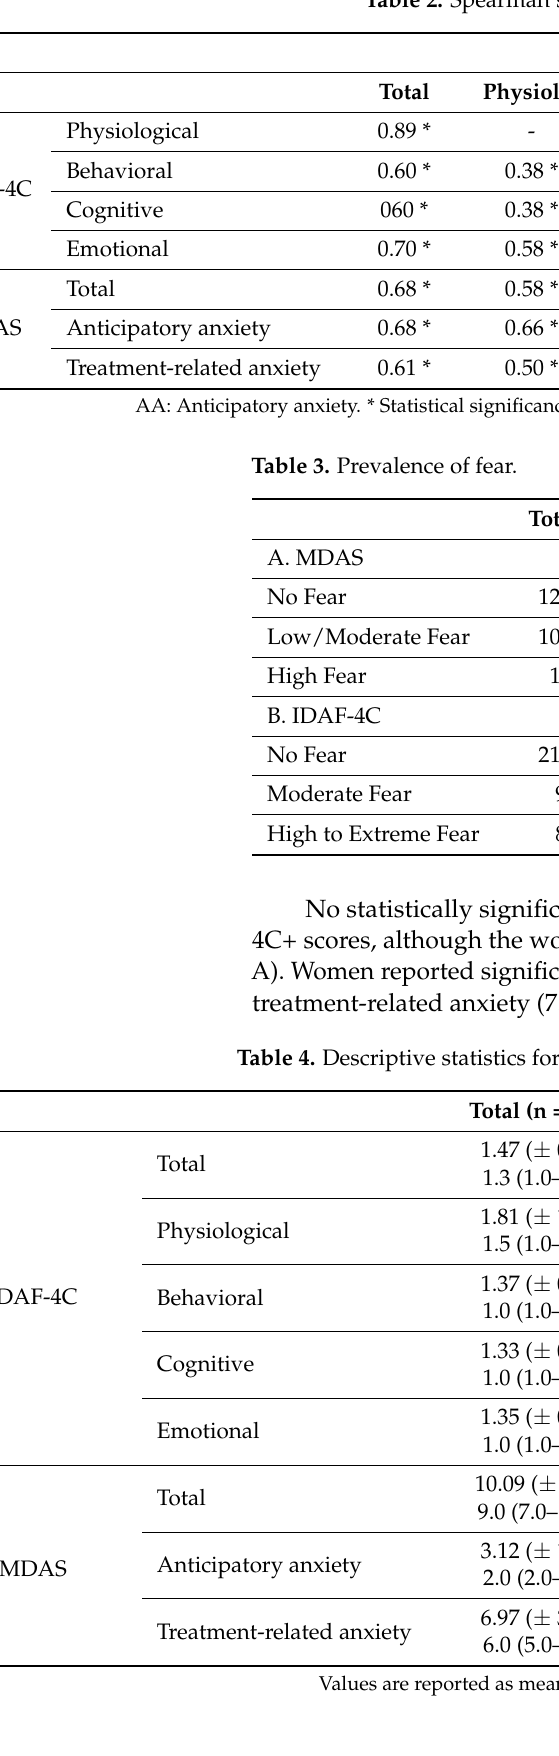
Table 2. Spearman’s correlation coefficient.